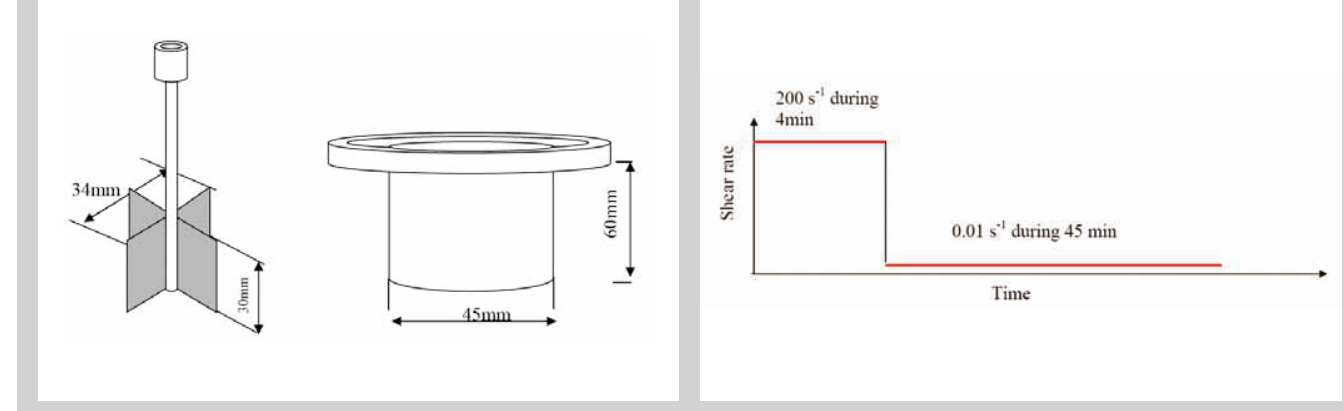
Figure 1 (left): Rheological measurement system: a) vane, b) inner cylinder. Figure 2: Flow path used to consider transient properties (thixo- tropy), including breakdown at a high shear rate and rebuild up at rest (very low shear